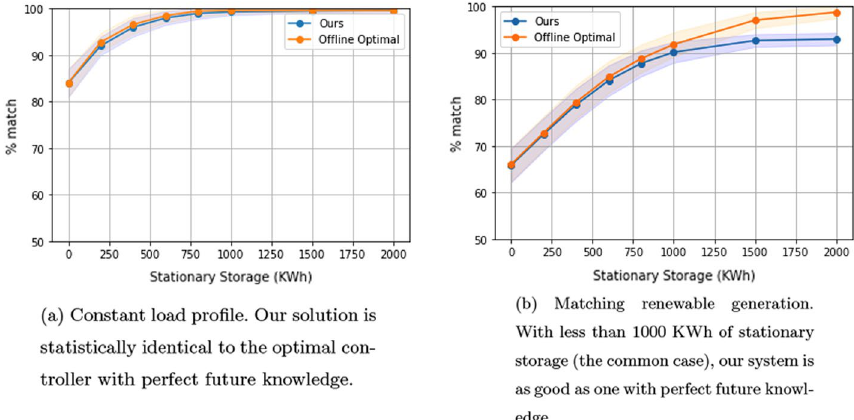
Fig. 2 Comparison of our solution to offline optimal. One-way charging in a residential setting